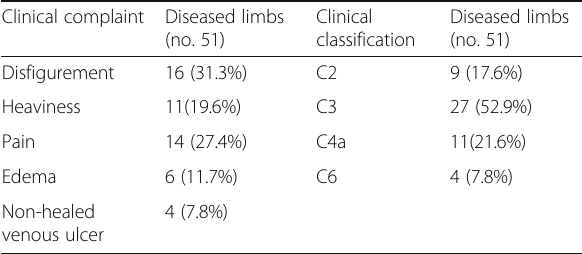
Table 2 Symptomatic and clinical distribution of